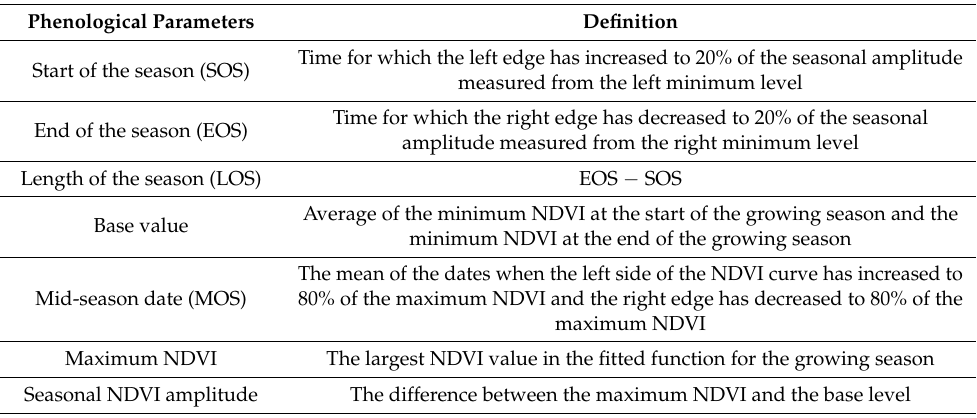
Table 2. Definitions of the phenological parameters used in the TIMESAT